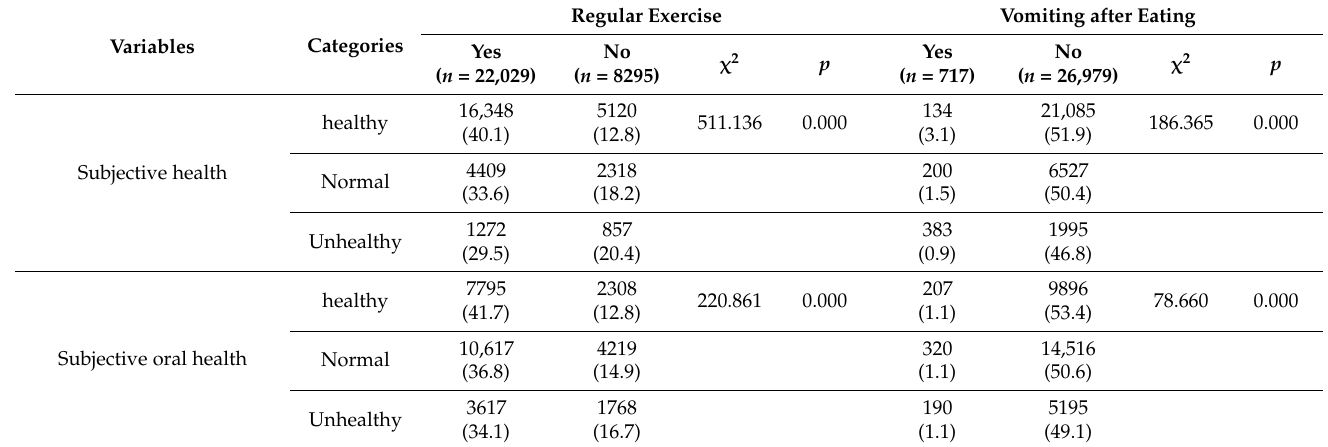
Table 3. Subjective health and subjective oral health according to the weight loss